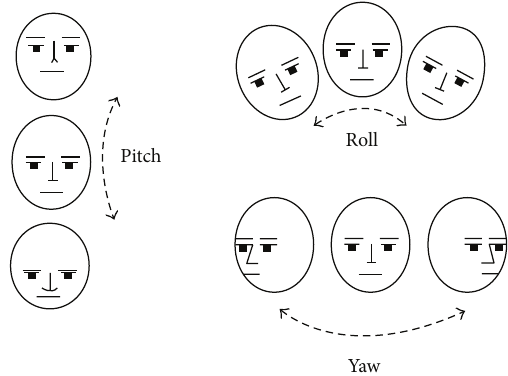
Figure 2: Head pose angles. The angles are expressed in degrees, with values ranging from − 180 degrees to +180 degrees. This figure has been extracted from the Face Tracking SDK Kinect for Windows available at http://msdn.microsoft.com/en-us/library/jj130970.aspx.